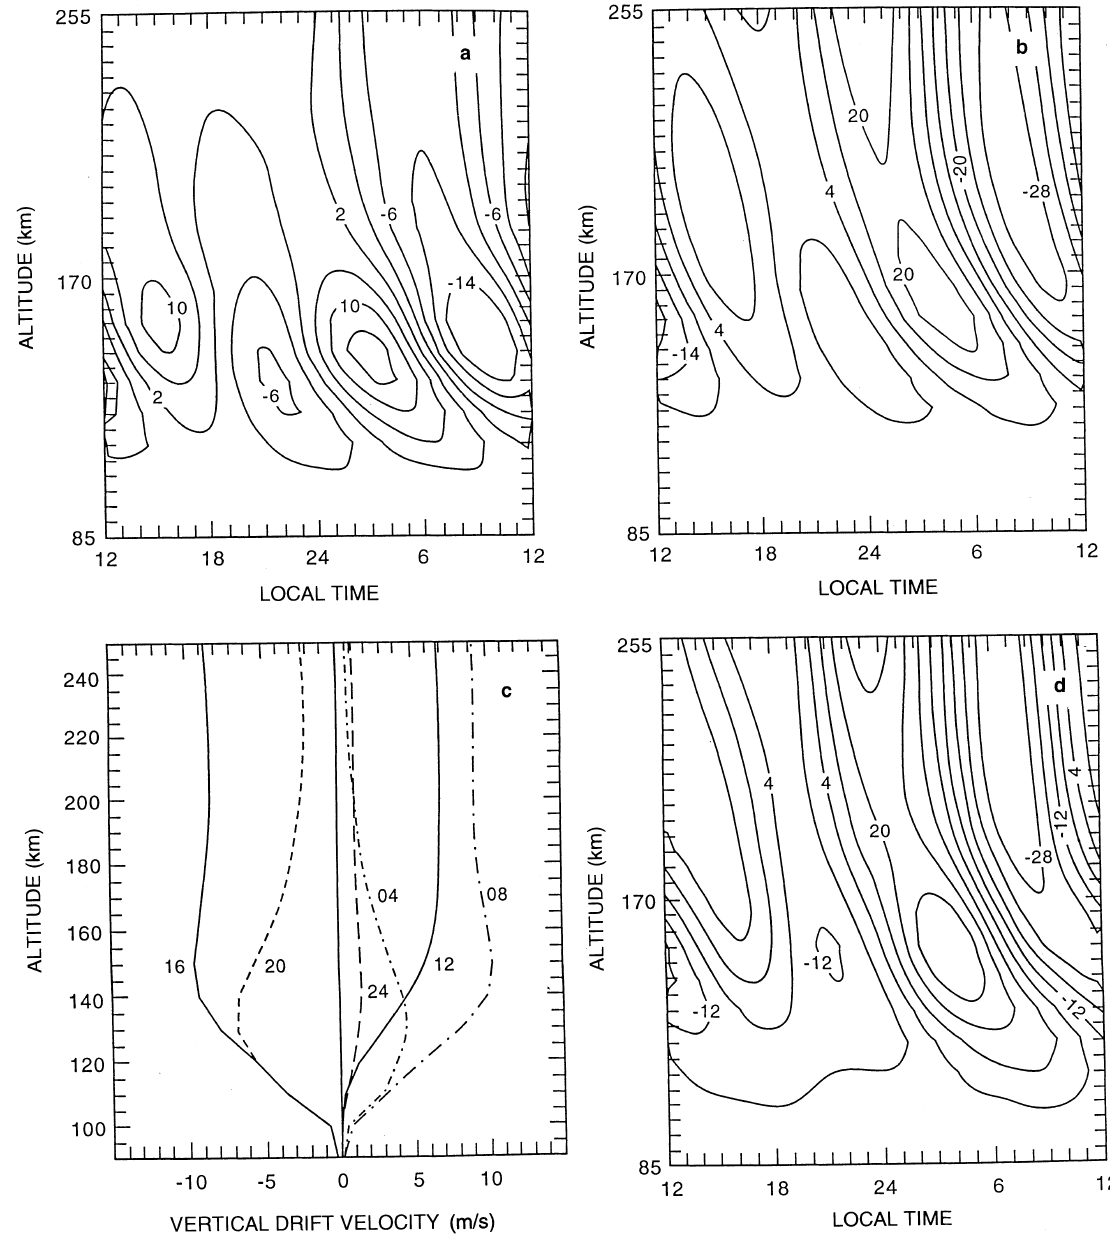
Fig. 4a–d. Vertical ion drifts at 18 (cid:176) latitude due to a zonal wind; b meridional wind; c electric field; d the combination of a , b and